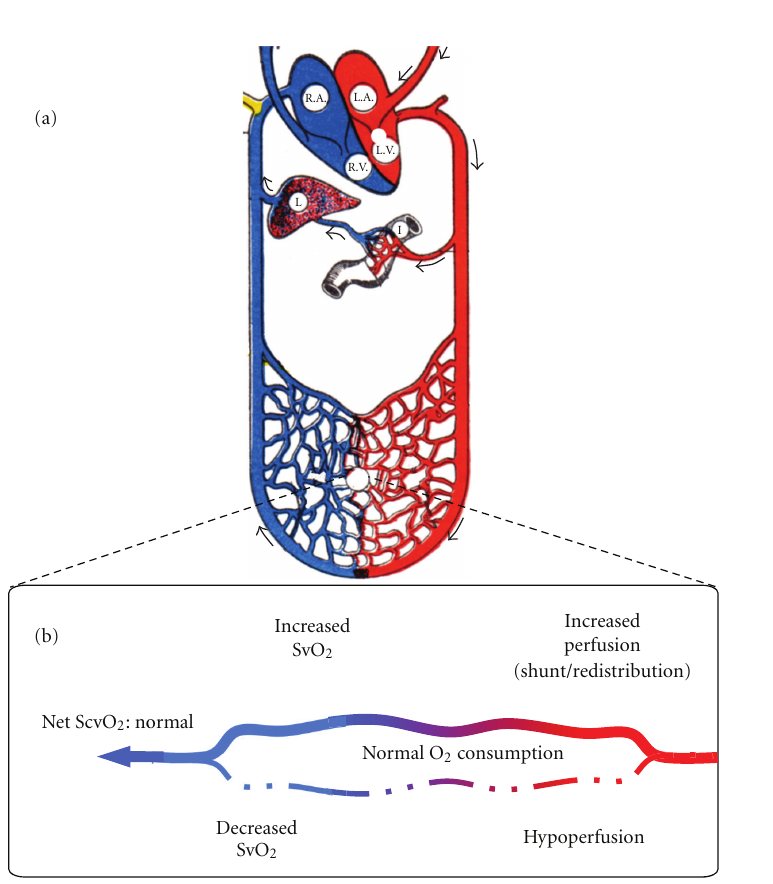
Figure 1: Capillary SvO 2 and perfusion. (a) Schematic representation of the circulation (arterial in red, venous in blue, R.A: right atrium, L.A: left atrium, R.V: right ventricle, L.V: left ventricle, I: intestine, L: liver) and a generic capillary bed. (b) Schematic representation of both a hypoperfused capillary (lower dashed line) and normally perfused capillary (upper continuous line) receiving increased perfusion redistributed from the hypoperfused capillary. Following normal oxygen consumption by the tissues adjacent to the capillaries, SvO 2 in each capillary is specified as is the resulting SvO 2 downstream of the heterogeneously perfused